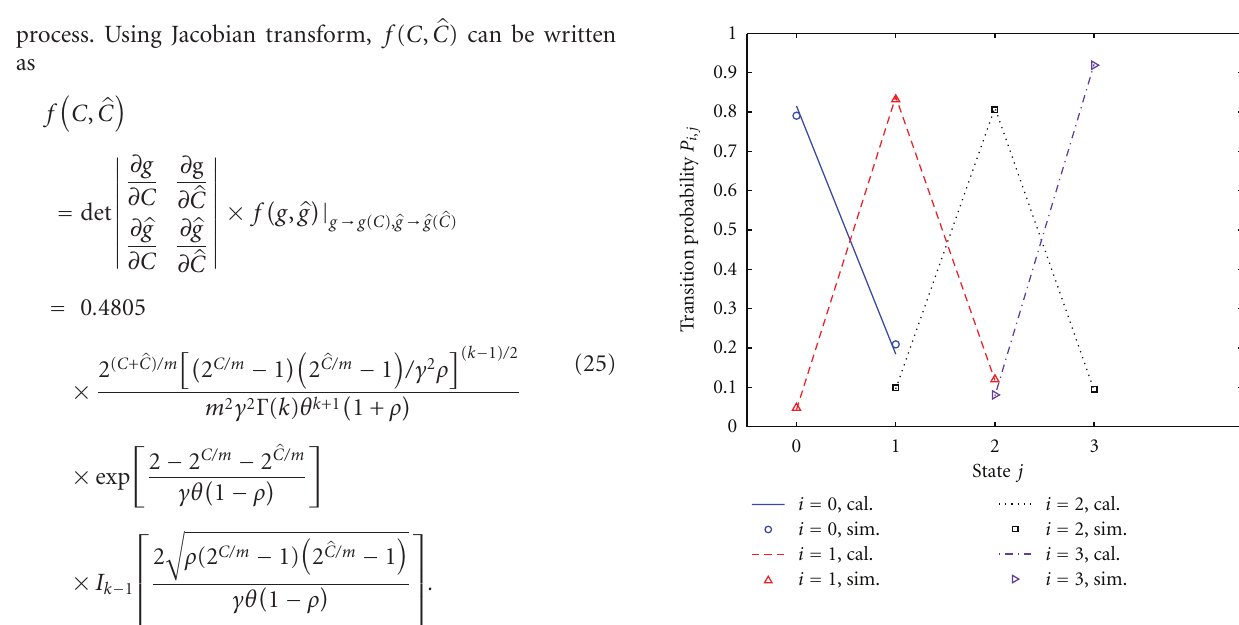
Figure 6: Comparison of approximated and simulated transition probabilities for link gains (with f D = 30 Hz, τ = 0 . 001 sec) in a (2,4) MIMO system.